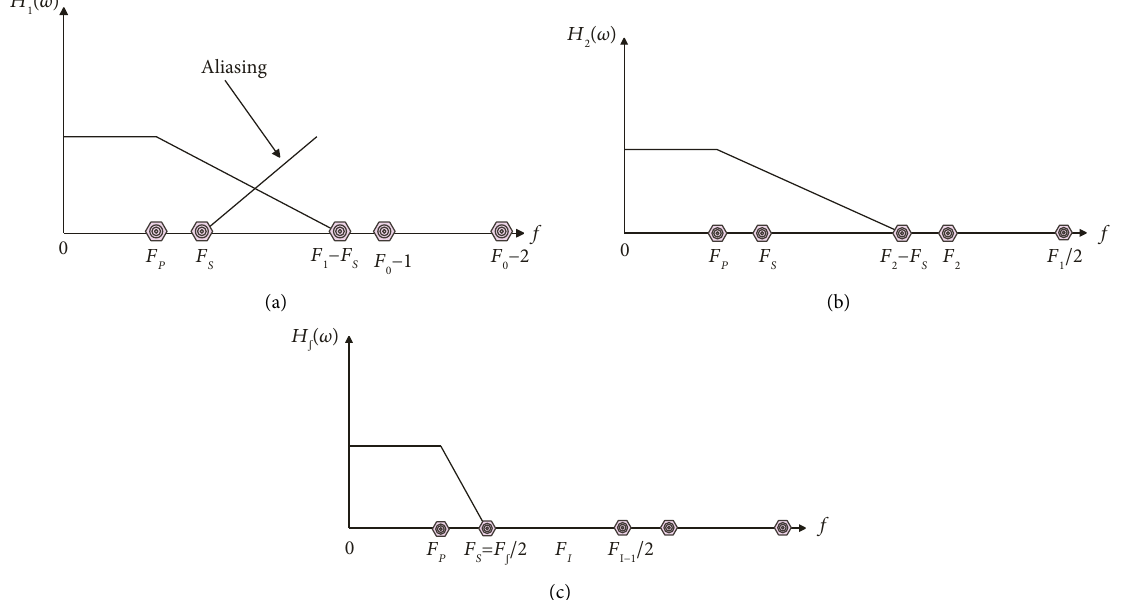
Figure 4: Spectrum diagram of decimation filter at all levels. (a) The first level of filtering parameters. (b) The second level of filtering parameters. (c) The I th level of filtering parameters.